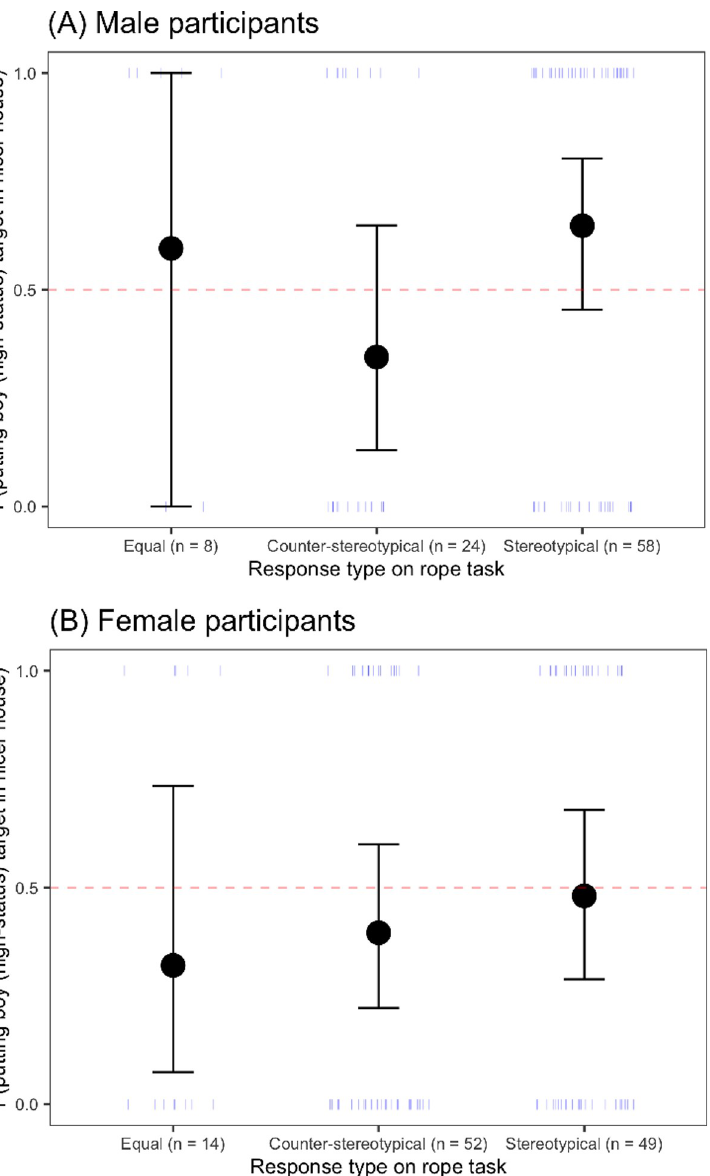
Fig 3. Probability of placing the boy (high-status) child in the nicer house in the wealth-matching task, as a function of response type on the rope task for (A) male participants and (B) female participants. The dotted line represents chance responding. Circles represent the means for each group, and error bars represent 95% confidence intervals around the means; dashes represent individual participants. higher in social status than boys at any age tested. Instead, younger female participants rated boys and girls equally and female participants’ ratings of girls’ status declined significantly with age. Among the oldest ages tested (which was still quite young, as the oldest children were still under 7 years old), female participants rated boys as having more social power than girls (as shown in Fig 2). This pattern is similar to research in other domains, including children’s stereotypes about intelligence [60]. In Bian et al.’s work, 6-year-old male participants rated their own gender as more likely to be “really, really smart,” but 6-year-old female participants